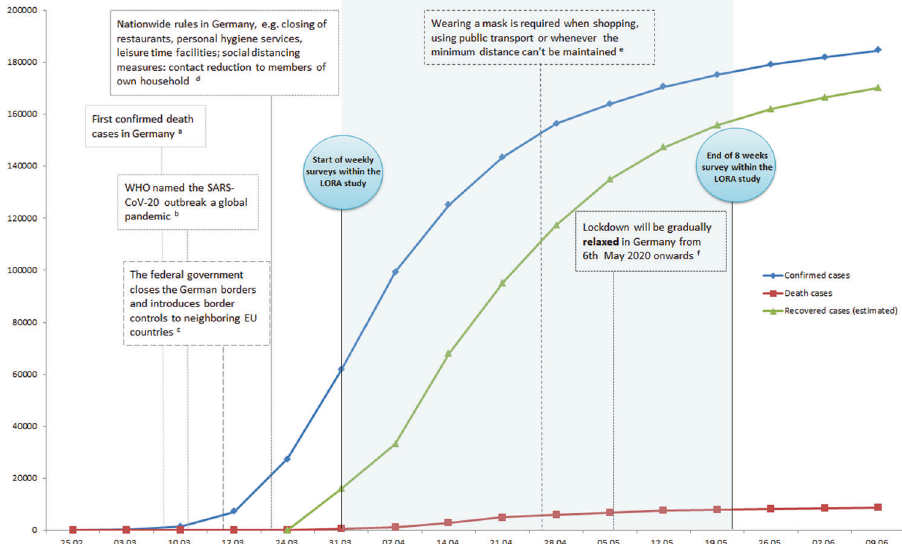
Fig. 1 Timing of data acquisition relative to the development of the pandemic in Germany. For footnotes, see the references, a [61], b [62], c [63], d [64], e [65], and f